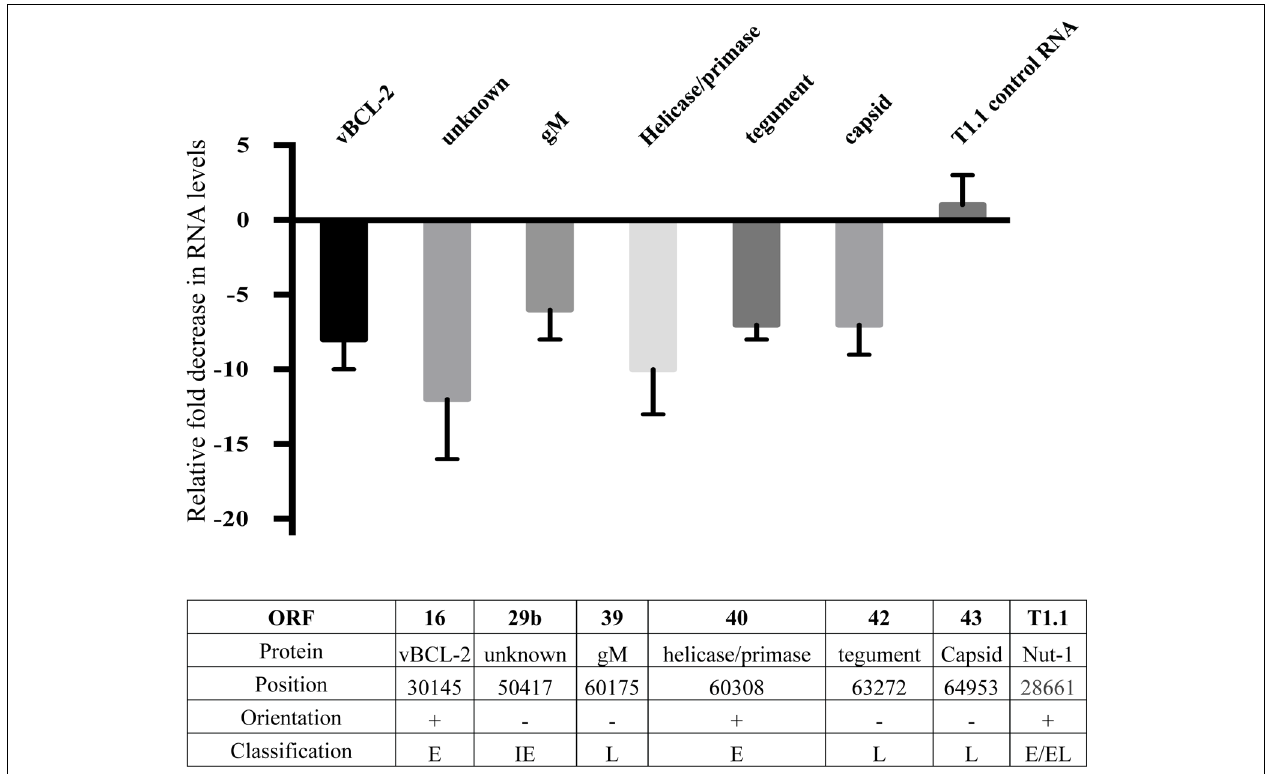
relative to No Inhibitor rKSHV.219 infected HF cells, which was set to 1. RNA levels were normalized using ribosomal RNA. Information below table identifies open reading frame, protein name, position in HHV8 genome, NF κ B consensus site upstream of gene, orientation of gene, and immediate early (IE), early (E), or late (L) gene